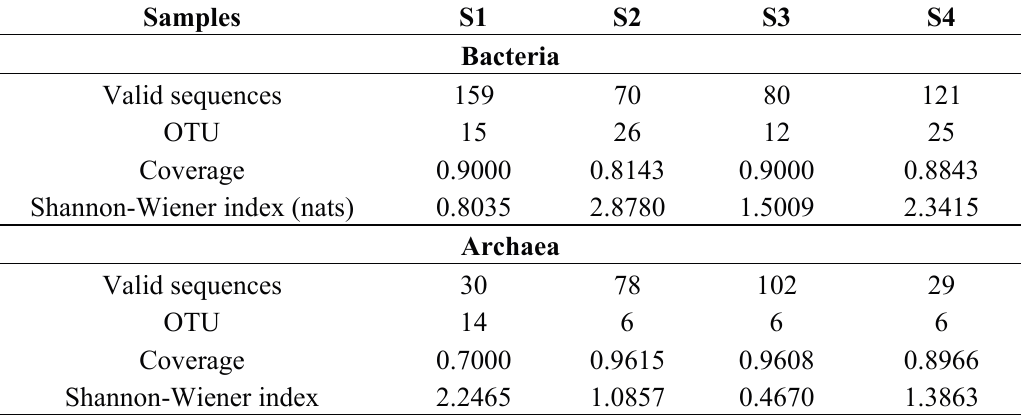
Table 2. 16S rRNA gene and clone library analysis information of